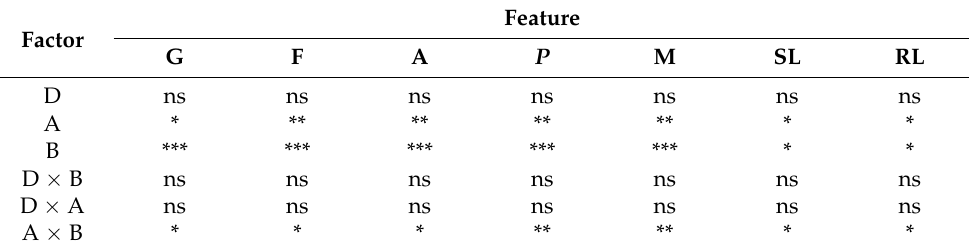
Table 9. ANOVA for assess the influence of year, cultivar and treatment on the tested features: germination (%), Fusarium sp. (%), Alternaria sp. (%), Penicillium sp. (%), Mucor sp. (%), shoot, and root length (cm).